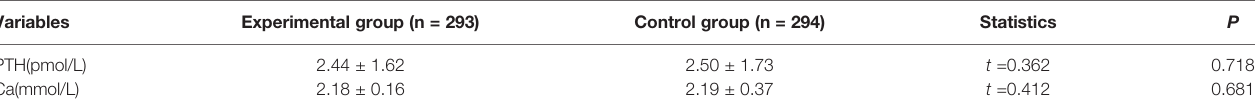
TABLE 7 | Comparison of changes in parathyroid function between the two groups.